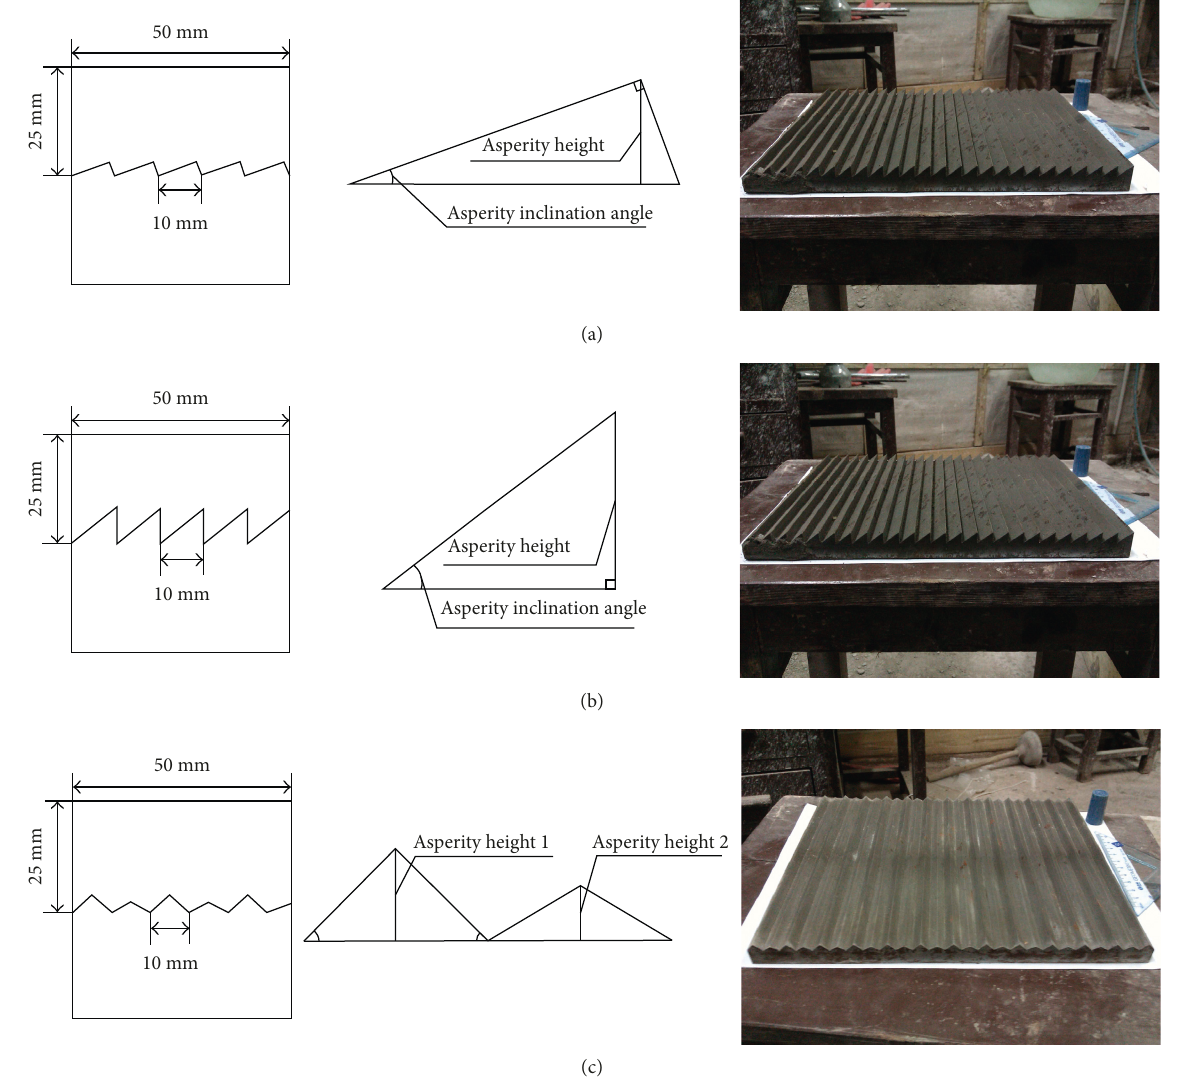
Figure 1: Roughness types. (a) Roughness type I model; (b) roughness type II model; (c) roughness type III model.